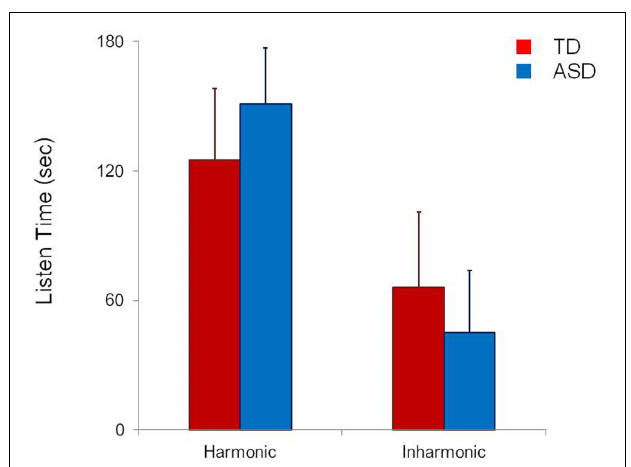
FIGURE 1 | Mean preference (error bars: SDs) for an original simple harmonic minuet of Mozart (Harmonic) and its modified inharmonic version containing many dissonant intervals (Inharmonic) in children with autism spectrum disorder (ASD) and in typically developing (TD) children.